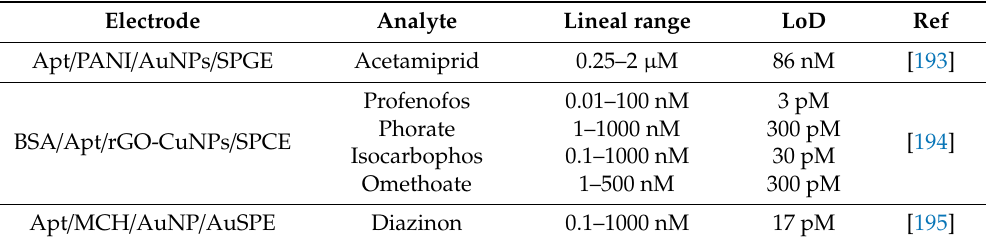
Table 5. Aptasensors reported for pesticides determination on screen-printed electrodes.